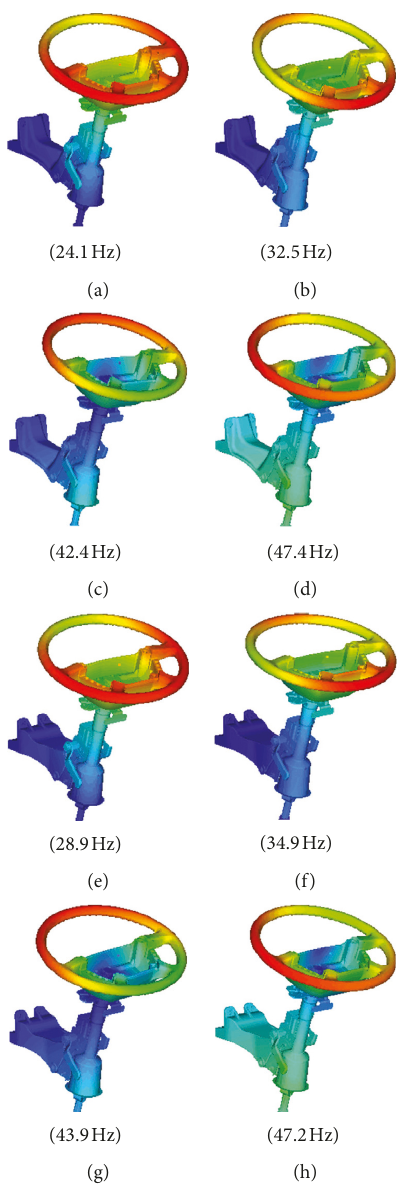
Figure 22: Comparison and analysis of the traditional model and improved model: (a)–(d) the first–fourth-order finite element modal of the traditional model and (e)–(h) is the first–fourth-order finite element modal of the improved model,